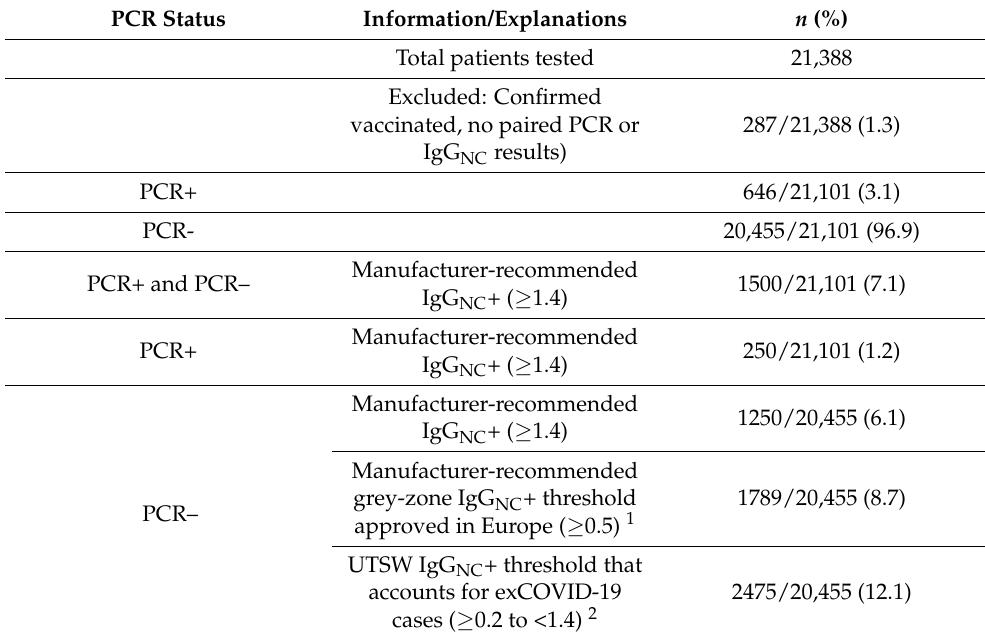
Table 2. Prospective comparison of SARS-CoV-2 RT-PCR with the IgG nucleocapsid assay (at different cut-off levels) for determining the ‘infection proportion’ in a unique Dallas/Fort Worth metroplex general